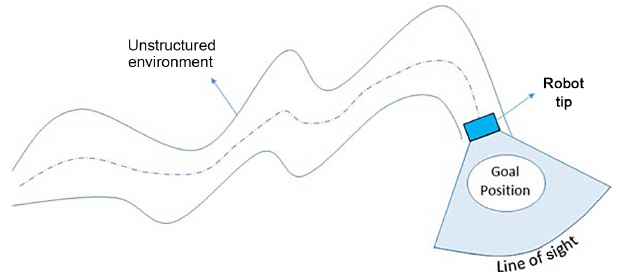
Figure 1. A robot navigating through an unstructured environment, serving a screening